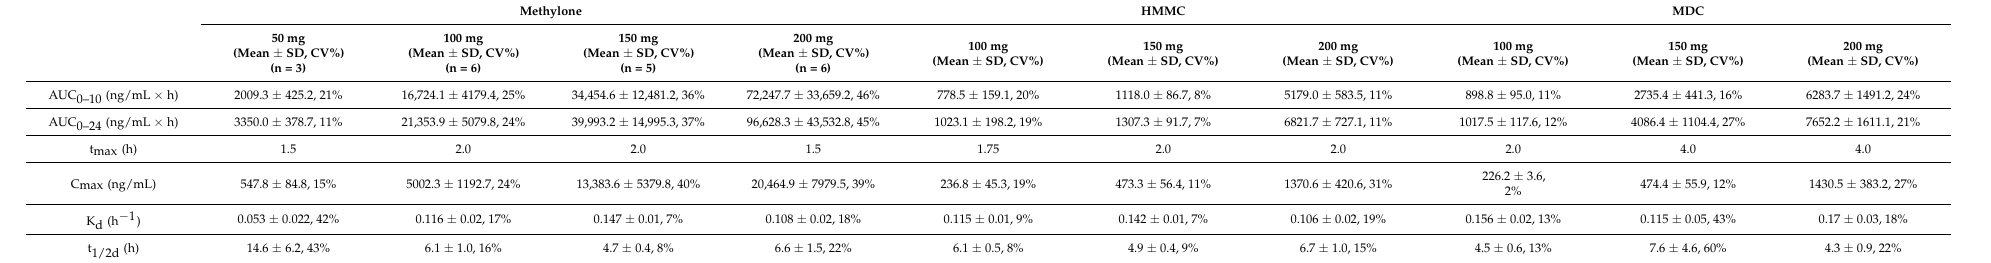
Table 2. Pharmacokinetic parameters for methylone and its metabolites in OF. Values are presented as mean + standard deviation (SD) and coefficient of variation (CV)